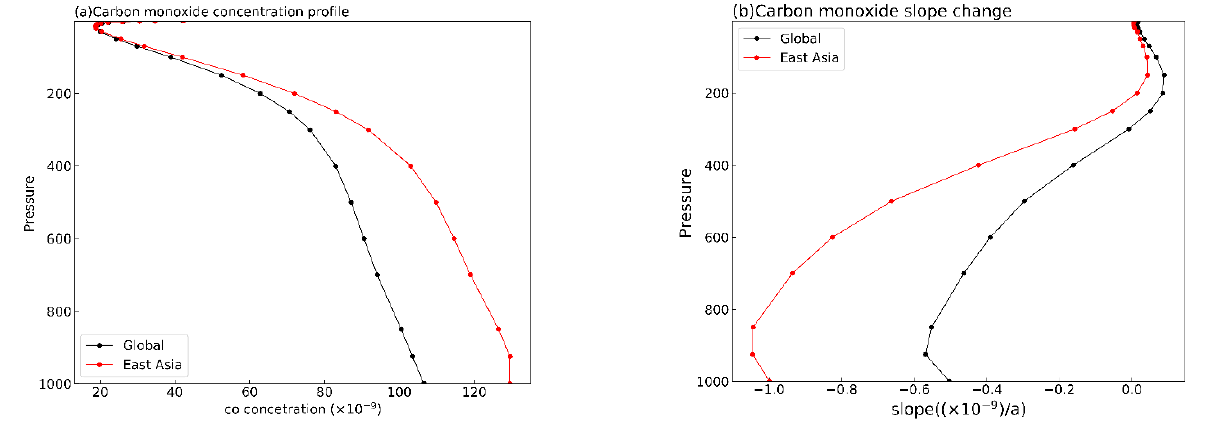
Figure 11. Profile and slope line chart of the world and East Asia from 2003 to 2021. ( a ) Profile map; ( b ) Slope map.